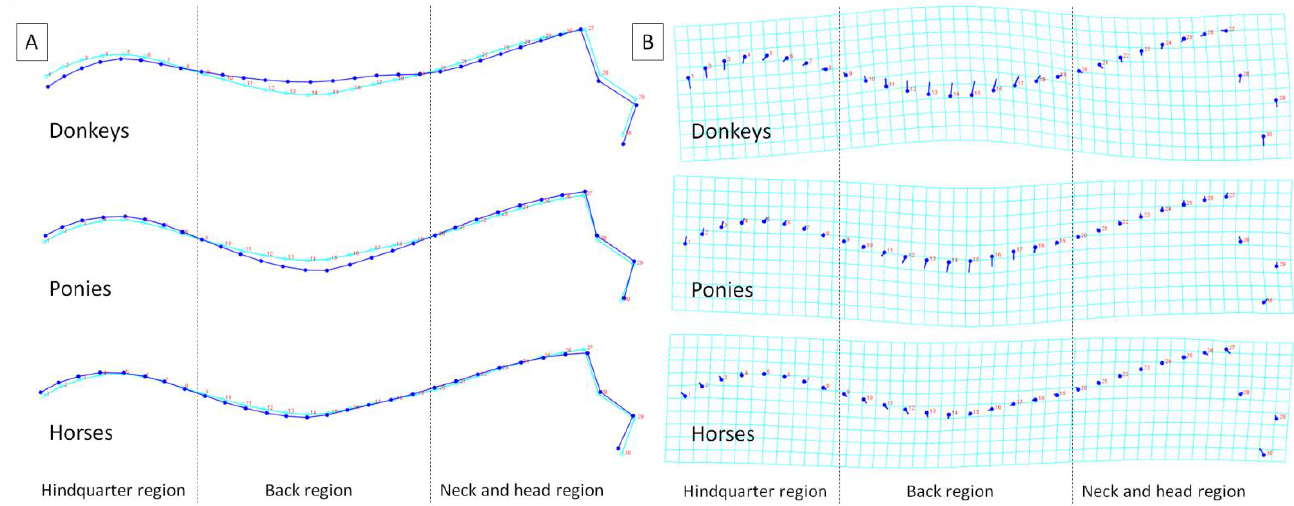
Figure 3. Average observations of the equid dorsal profiles of donkeys, ponies, and horses and represented by ( A ) the wireframe graphs and ( B ) the transformation grids. On the wireframe graphs, light blue landmarks and curves represent the consensus dorsal profile of the animals and dark blue landmarks and curves represent average observations for the subsequent groups. On the transformation grid, dark blue landmarks represent the consensus dorsal profile of the animals, and dark blue lines represent the average observations for subsequent groups. Dashed lines indicate the boundaries between regions.